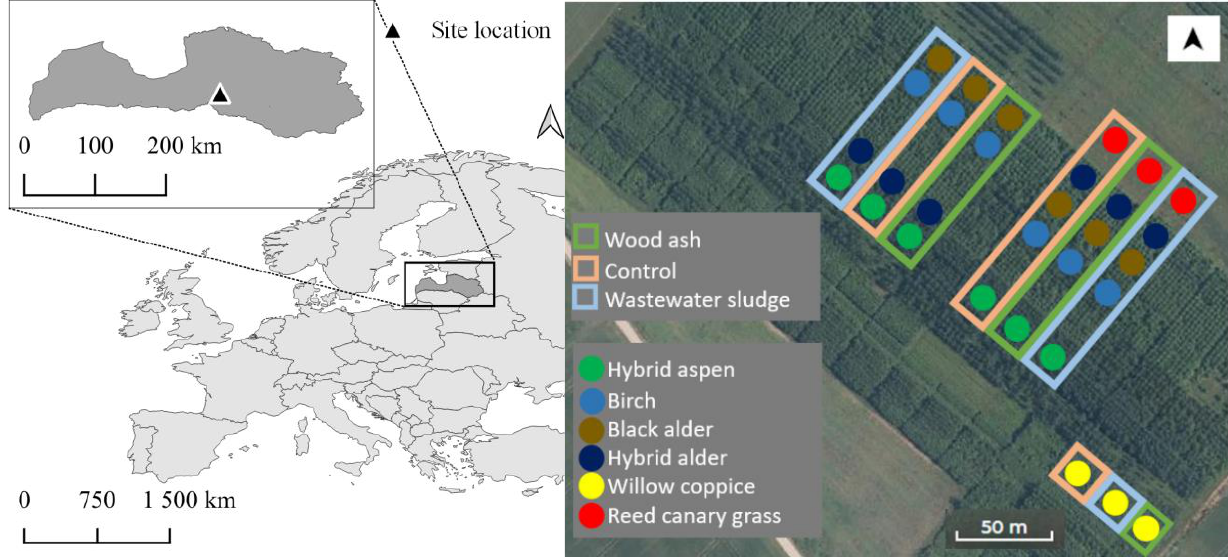
Figure 1. Location of the study site in Latvia.